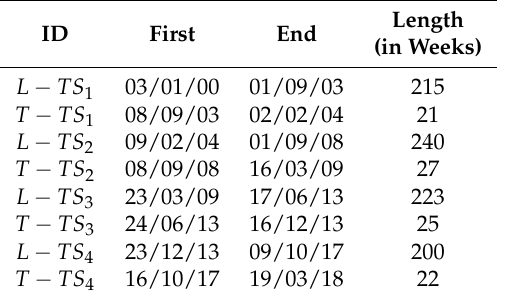
Table 7. Labels and length of each block of data employed in the trials. ID